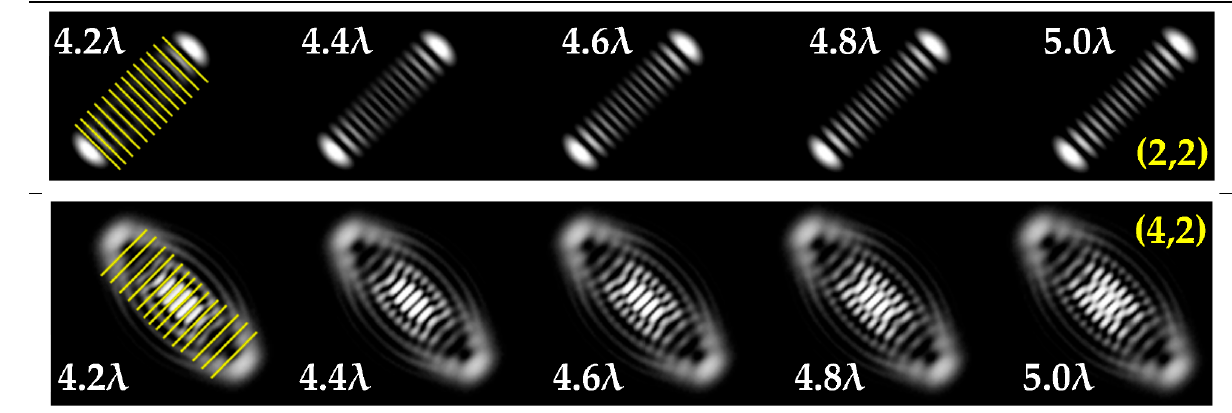
Figure 4. Detailed simulation results for multi-channel DOE matched with one type of aberration Z 2,2 ( r , ϕ ) and Z 4,2 ( r , ϕ ) with α ranging from 4.2 λ to 5 λ when illuminated with a vortex beam with TC l = 14.